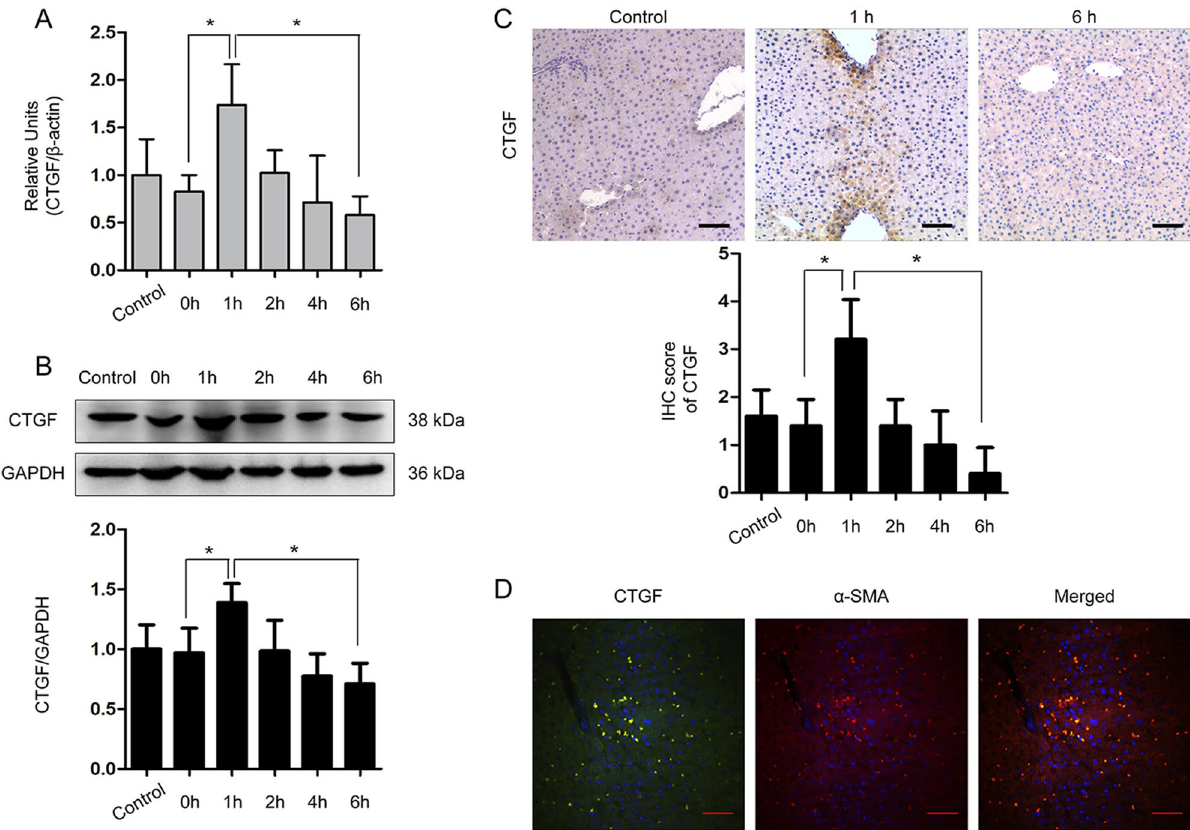
Figure 2. Expression dynamics of CTGF in the non-steatotic liver from the rat brain death model (n = 5 for each time point) . Dynamic expression of CTGF in the non-steatotic liver from the rat brain death model determined by ( A ) RT-qPCR, ( B ) WB, and ( C ) IHC (* P < 0.05 compared with 0 h). ( D ) Double immunofluorescence of CTGF (green) and α-SMA (red) in the rat liver 1 h after brain death (scale bar = 20 μm, ×200 magnification). The shame-operated rats were regarded as